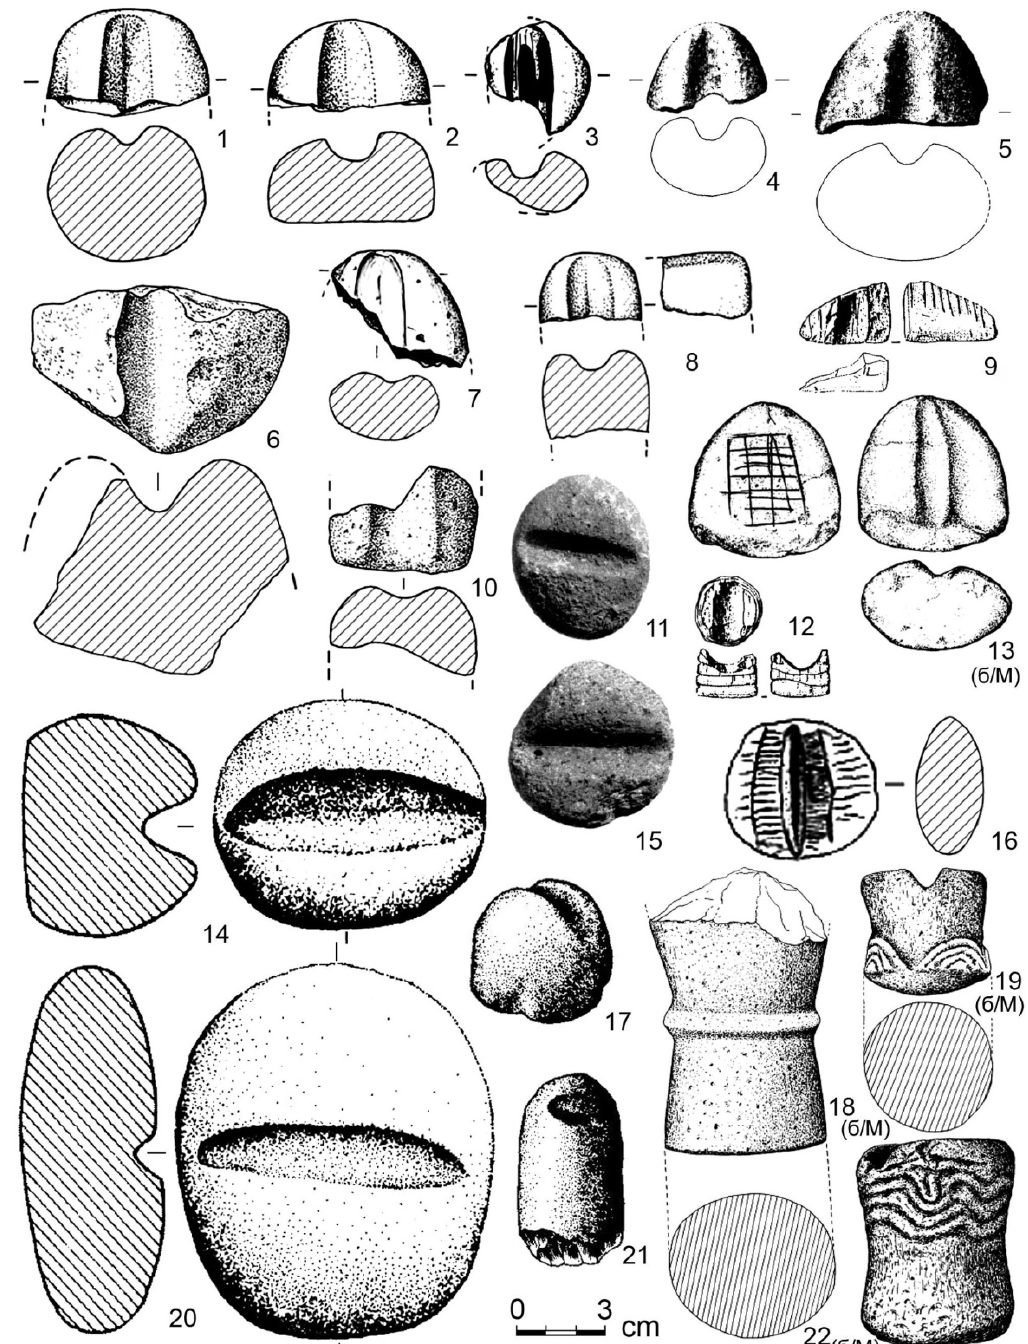
Figure 2. Natufian grooved stones (the Levant). 1-3, 6-8, 10: el-Wad Terrace (Rosenberg et al . 2012: 113, fig. 20, 1, 2, 4-6, 10; fig. 21, 2); 4-5: Beidha (Byrd 1991: 251, fig. 4, e, f); 9, 12: Hayonim Cave, Layer B (Belfer- Cohen 1991: 576, fig. 6, 6-7); 11, 15: Saaïdé II (Schroeder 1991: 76, fig. 14, 1, 2); 13, 18, 19, 22: Nahal Oren (Noy 1991: 560, fig. 2, 5; 562, fig. 3, 1-3); 14, 20: Ali Kosh, Jericho (Kozlowski & Aurenche 2005: 158,